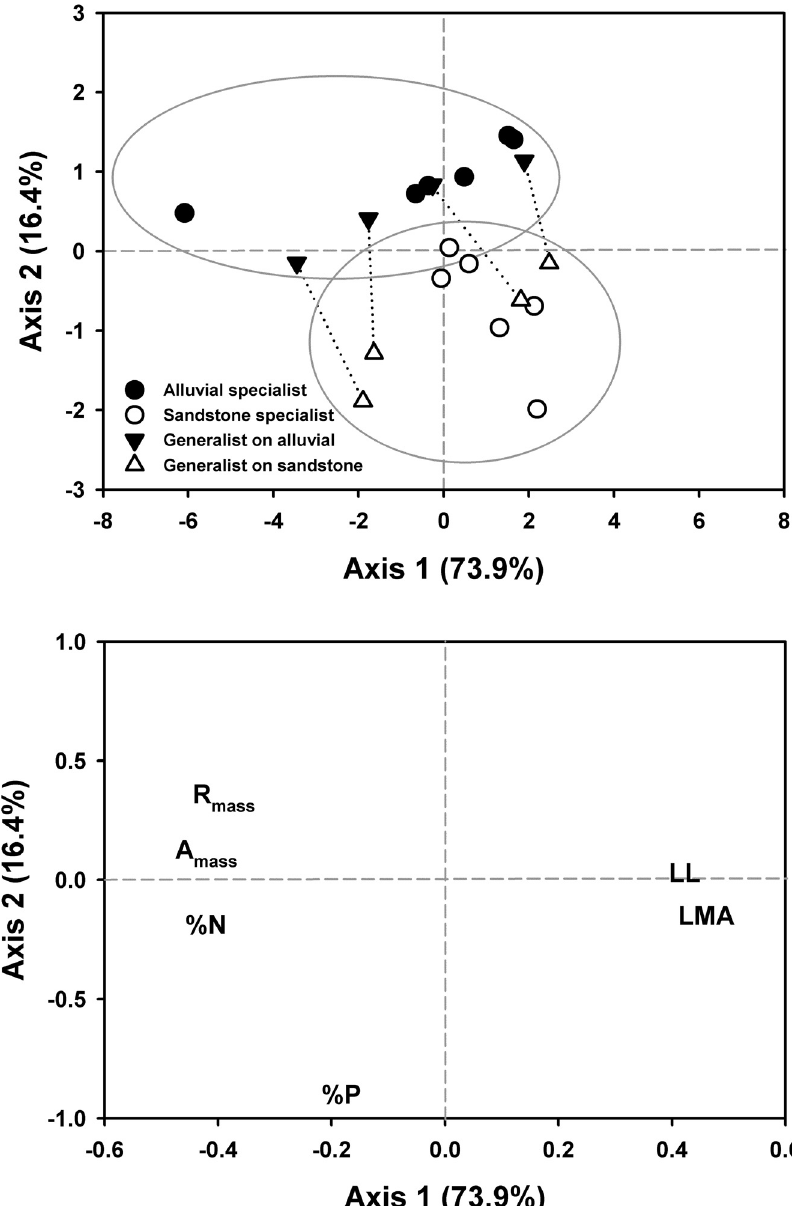
Figure 1. Prinicipal components analysis of the six key leaf economics traits (log-10 transformed). Two significant axes were detected, the first corresponding with the LES with A mass , R mass , %N and %P loading negatively along the first axis and LMA and LL loading positively (see Table 1 for loading values). The second significant axis corresponds primarily with foliar P concentrations, which load positively with the second axis. Species’ loading values are represented on the graph according to the habitat on which they were sampled (closed symbols, alluvial; open symbols, sandstone) and their behaviour as specialists (circles) or generalists (triangles). The two habitat classifications separated significantly along the second axis (Kruskal-Wallis x 2 =13.72,df=1,P=0.0002).Generalist speciesare represented bytwo data pointseach:one fromthe populationonthe alluvial soils (blacktriangles)and one from the sandstone soils (white triangles) and connected by a dashed line to demonstrate shifts in loading values between populations.